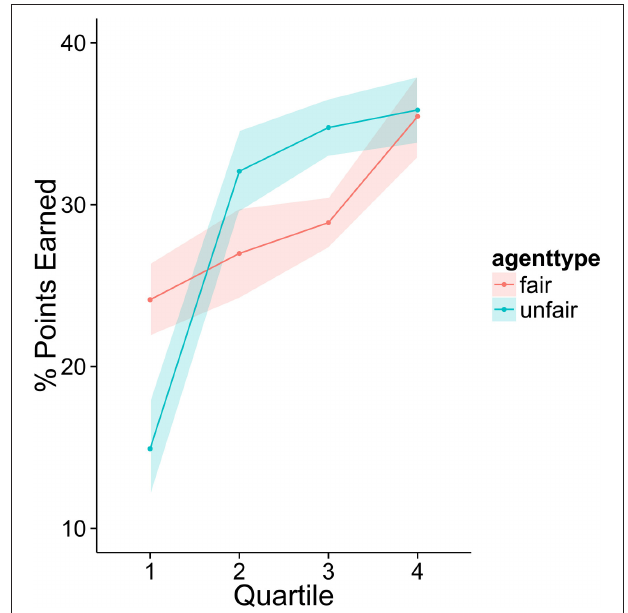
FIGURE 3 | Average number of points scored against each agent by members of each quartile.